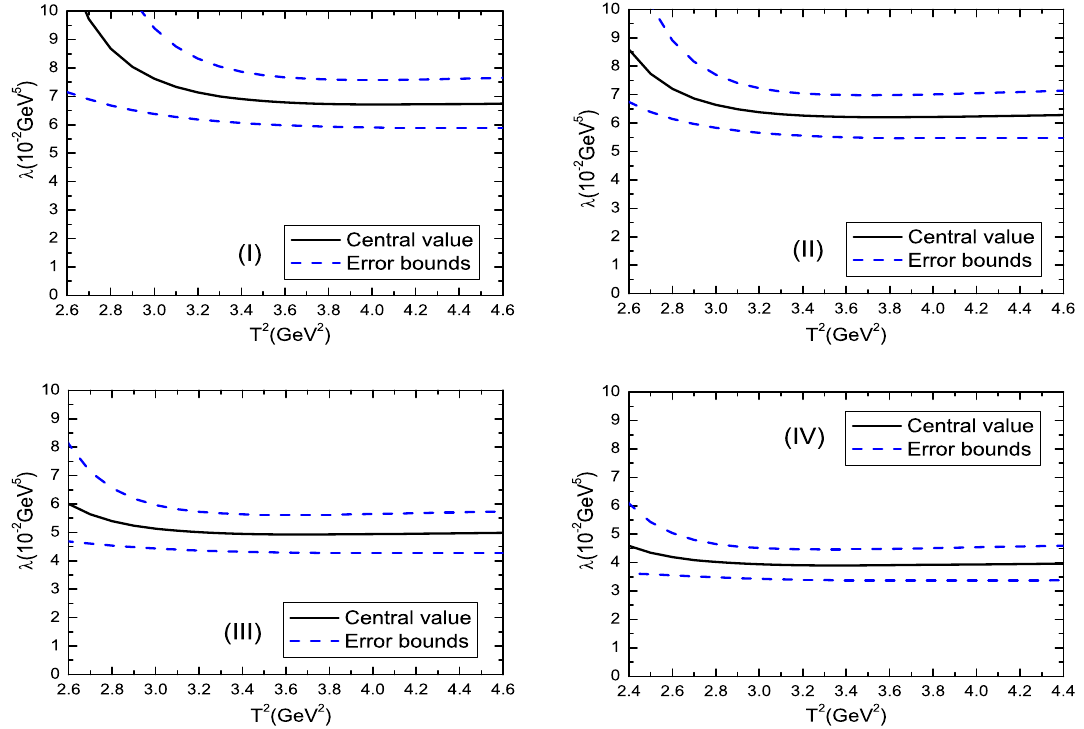
Fig. 2 The pole residues of the vector tetraquark states with variations of the Borel parameters T 2 , where the (I), (II), (III) and (IV) denote